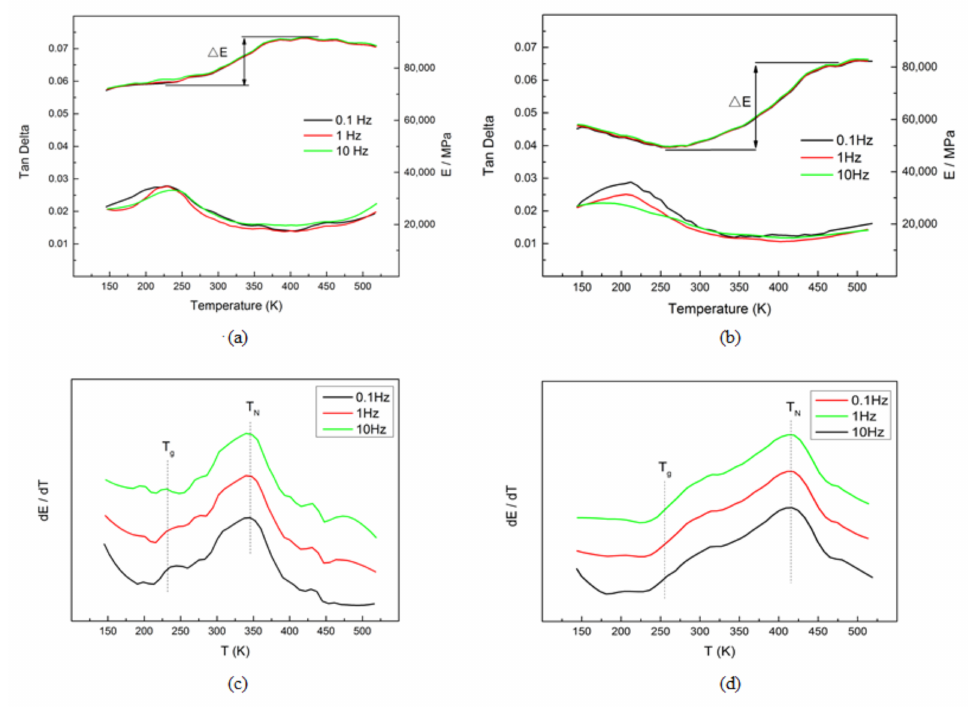
Figure 2. Relationship between tan δ , Young’s modulus, and temperature of the M2052 alloy ( a ) as-deposited and ( b ) after aging. Relationship between d E /d T and temperature of M2052 al- loy ( c ) as-deposited and ( d ) after aging.